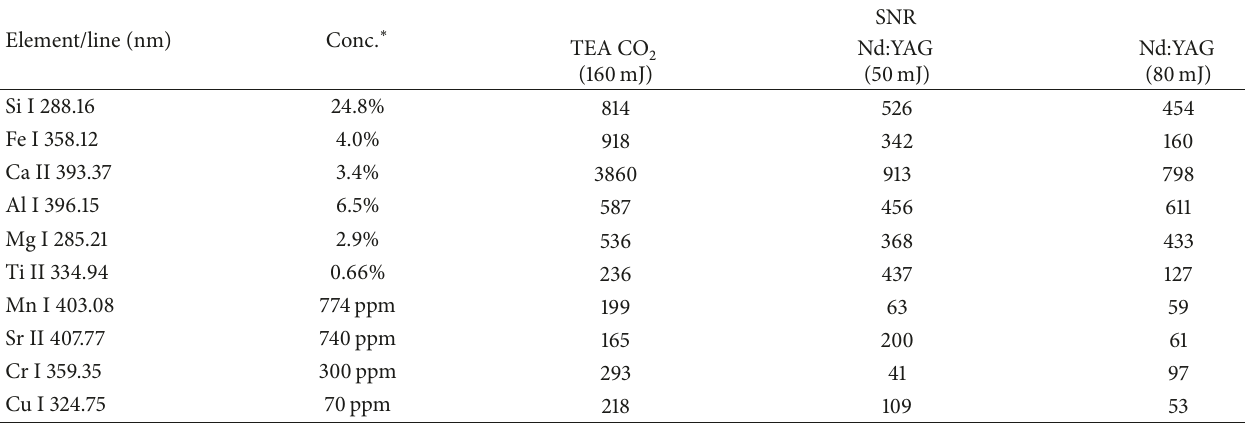
Table 4: Comparison of signal-to-noise (SNR) ratio for the elements under study, obtained for TEA CO 2 and Nd:YAG laser induced plasma over basalt sample in air at atmospheric